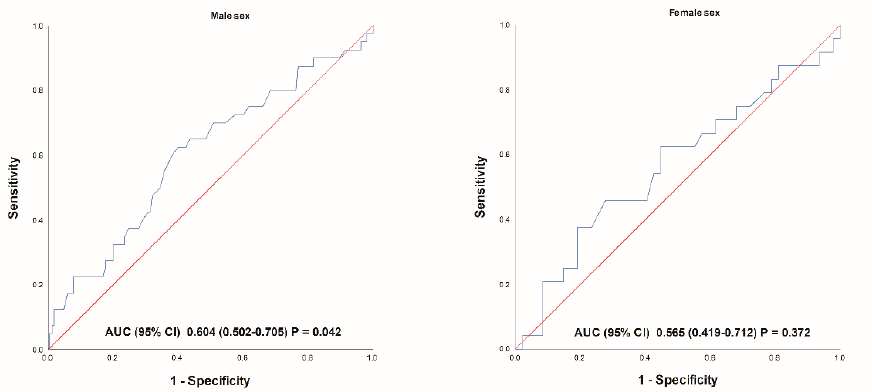
Figure 4. Event-free survival for MACCE according to sex in the propensity score matched cohort. Propensity score matching analysis with a nearest neighbor matching algorithm for age, BMI and eGFR (1:1 allocation and a caliper of 0.01). Legend: MACCE, major adverse cardiovascular and cer- ebrovascular events (composite of cardiac mortality, ischemic stroke, urgent coronary revasculari- zation and nonfatal myocardial infarction).